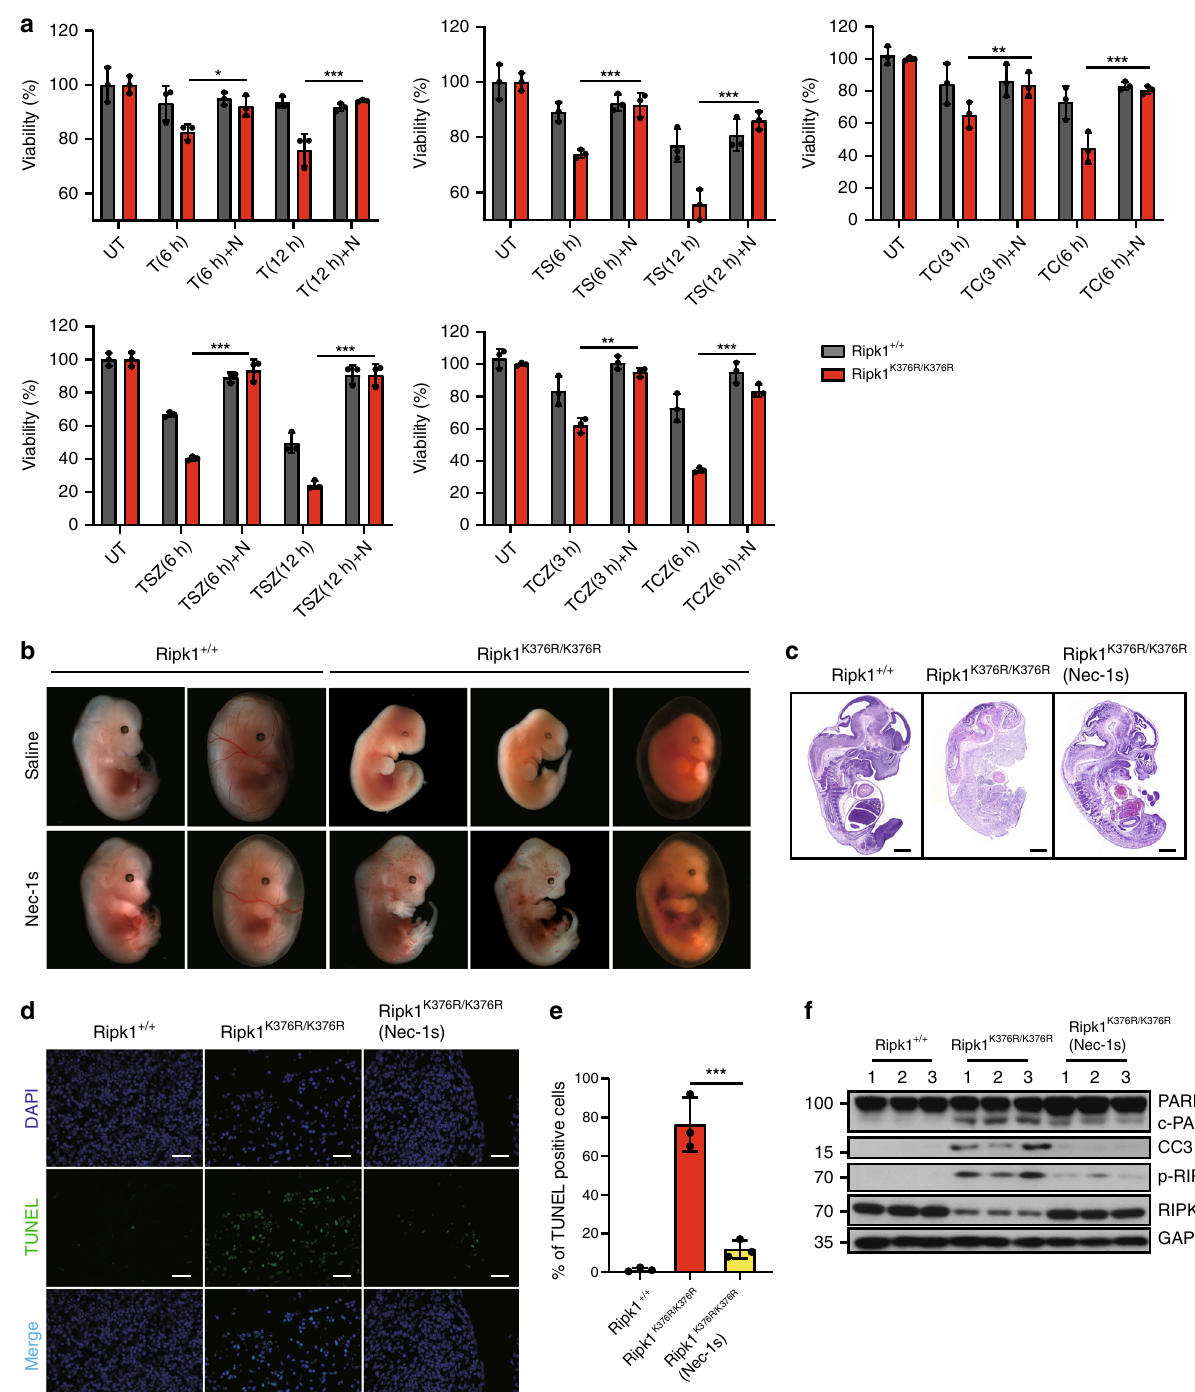
Fig. 4 Treatment of Nec-1s inhibits cell death induced by RIPK1 K376R. a Ripk1 + / + and Ripk1 K376R/K376R MEFs were treated with T, TS, TSZ, TC, TCZ for indicated times with or without Nec-1s as indicated. Cell viability was determined using the CellTiter-Glo kit. The data are represented as the mean ± SEM ( n = 3). P values were determined by Student ’ s t -test (* p < 0.05, ** p < 0.01, *** p < 0.001). Source data are provided as a Source Data fi le. b Pregnant Ripk1 K376R/ + females were fed with Nec-1s (50 mg/kg) or saline solution once per day since day 9.5 of gestation and sacri fi ced on day 13.5. Representative embryos with indicated genotypes were presented. c Representative H&E staining (scale bars, 1 mm) and d TUNEL staining of fetal livers from mouse embryos of the indicated genotypes. Each image is representative of at least three embryos. Scale bars, 50 μ m. e Quanti fi cation of TUNEL positive cells in Fig. 4d. The results are represented as ± SEM of three embryos per group. P value was calculated by Student ’ s t -test (*** p < 0.001). Source data are provided as a Source Data fi le. f The fetal liver samples from three embryos per group were analyzed by western blot and immunoblotted with PARP, CC3, p-RIPK1(S166), and